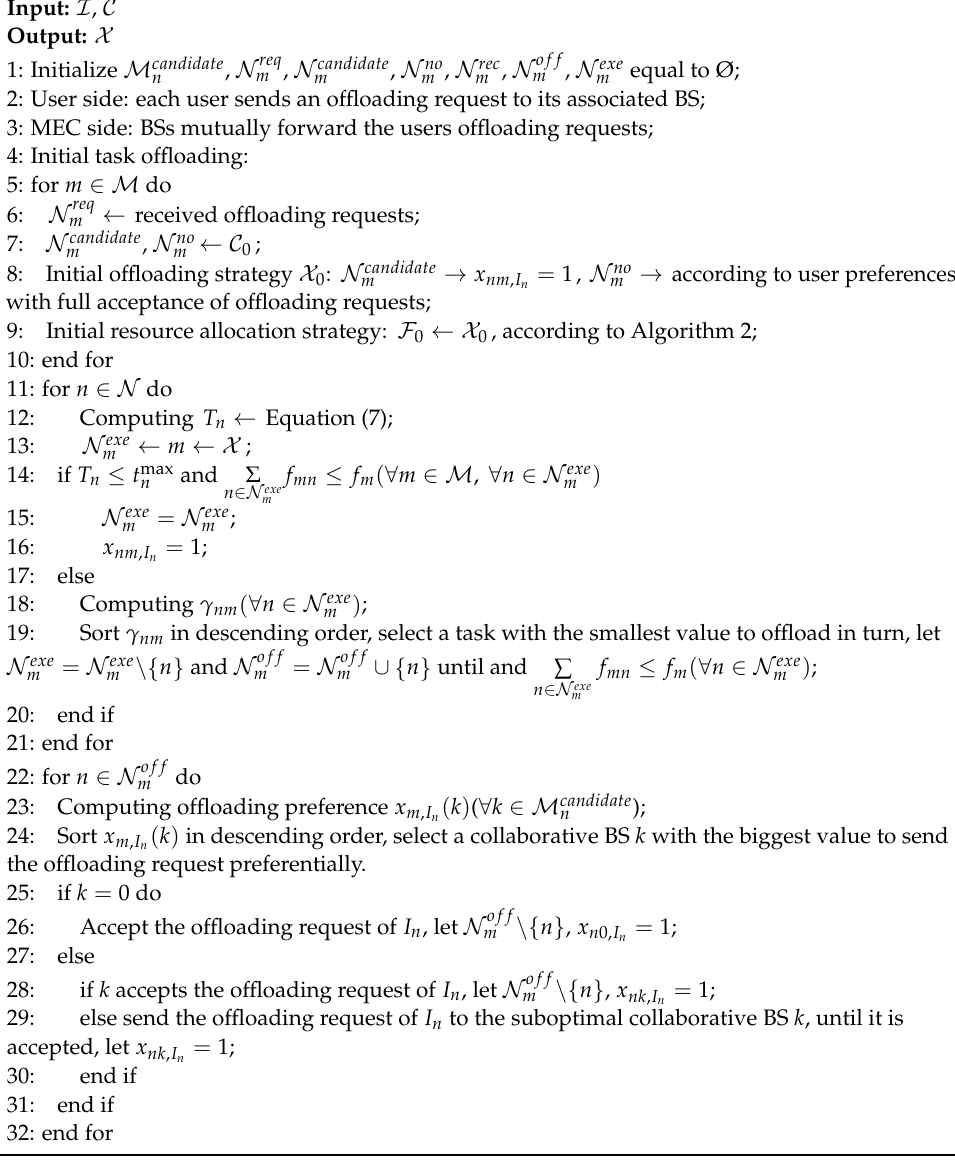
Algorithm 3: Preference-Based Bilateral Matching Offloading